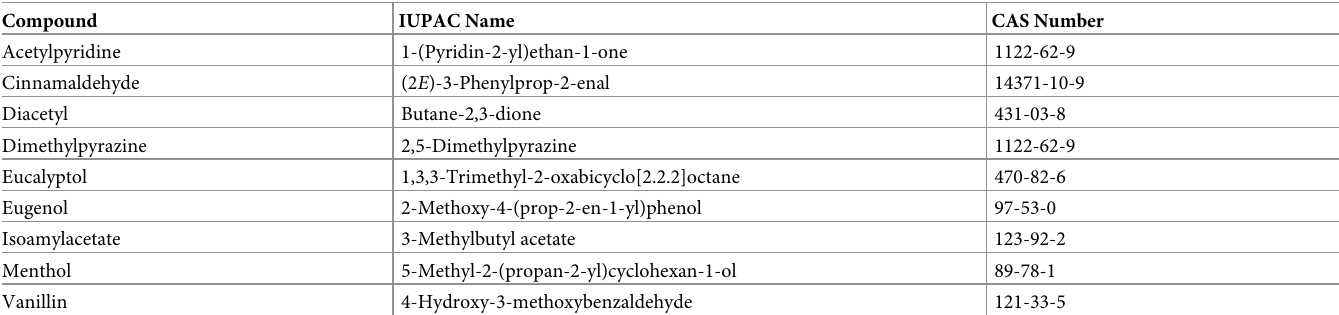
Table 1. Flavorings tested in this study (in alphabetical